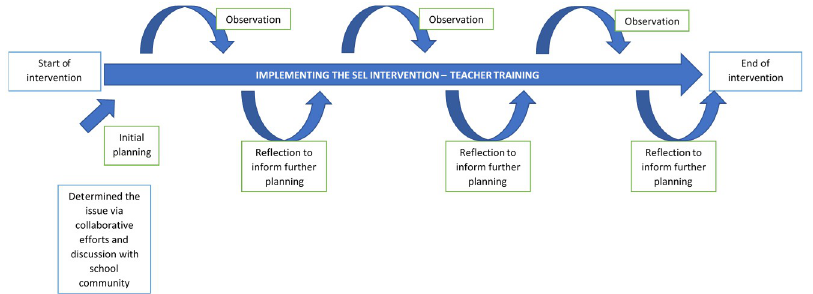
Fig 3. Integration of PAR into the SEL intervention–the iterative reflective inputs and feedback from teachers during their training sessions will be integrated into the planning of subsequent training sessions throughout the intervention